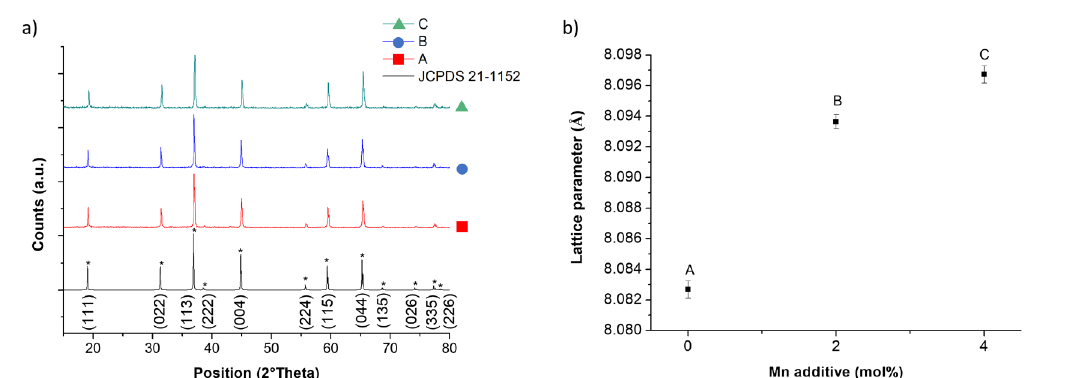
Figure 6. X-ray diffraction patterns of samples sintered at 1350°C (a) and the calculated cell parameters of each composition (b)